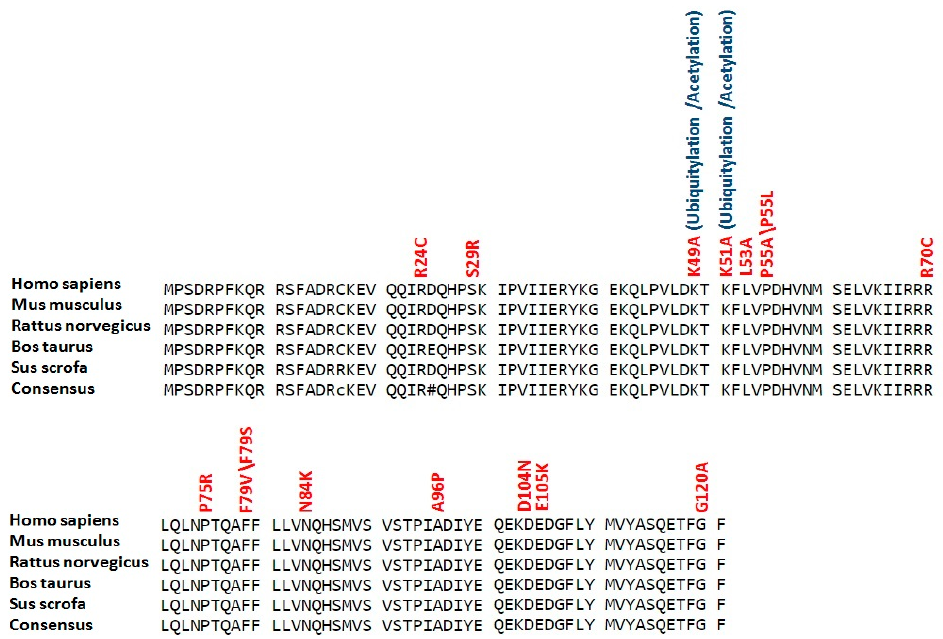
Figure 2. Conservation analysis of potential modified residues in LC3A protein. Sequences of LC3A proteins (human, mouse, rat, cattle and pig) were aligned using Multalin version 5.4.1 (http://multalin.toulouse.inra.fr/multalin/). High risk deleterious missense SNPs are mentioned in red color at respective positions while overlap with various types of posttranslational modifications are given in blue color.